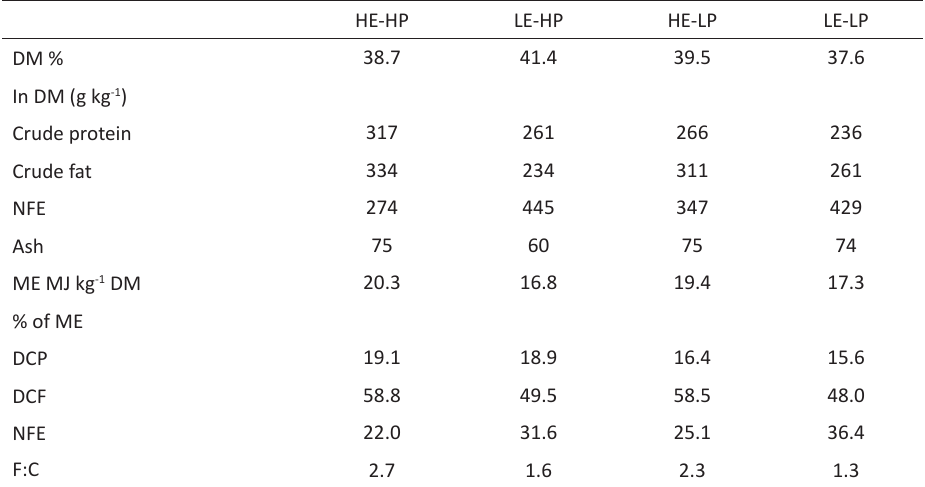
Table 2. Analysed chemical